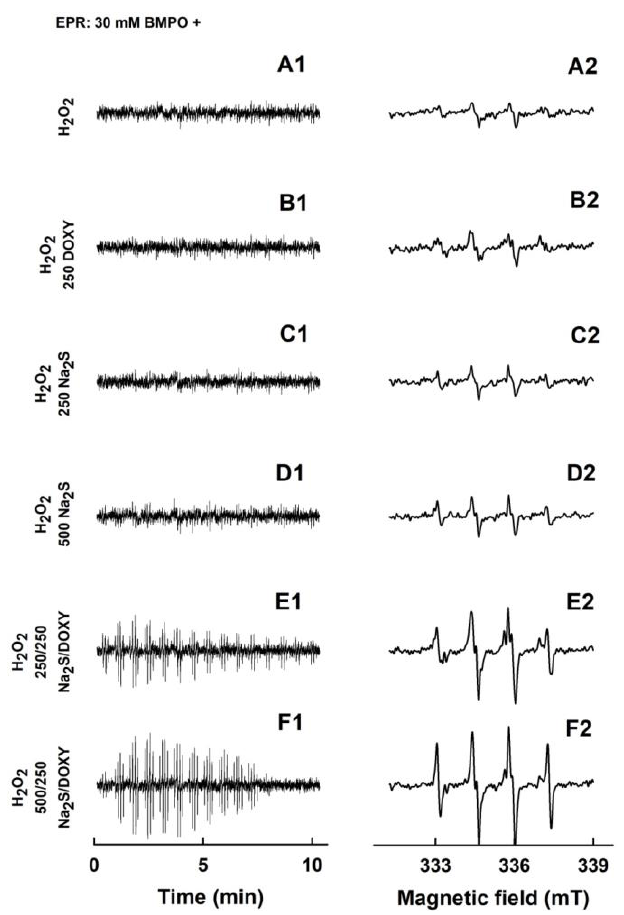
Figure 7. EPR spectra of the • BMPO-adducts for H 2 O 2 , Na 2 S, DOXY and their mutual combinations.